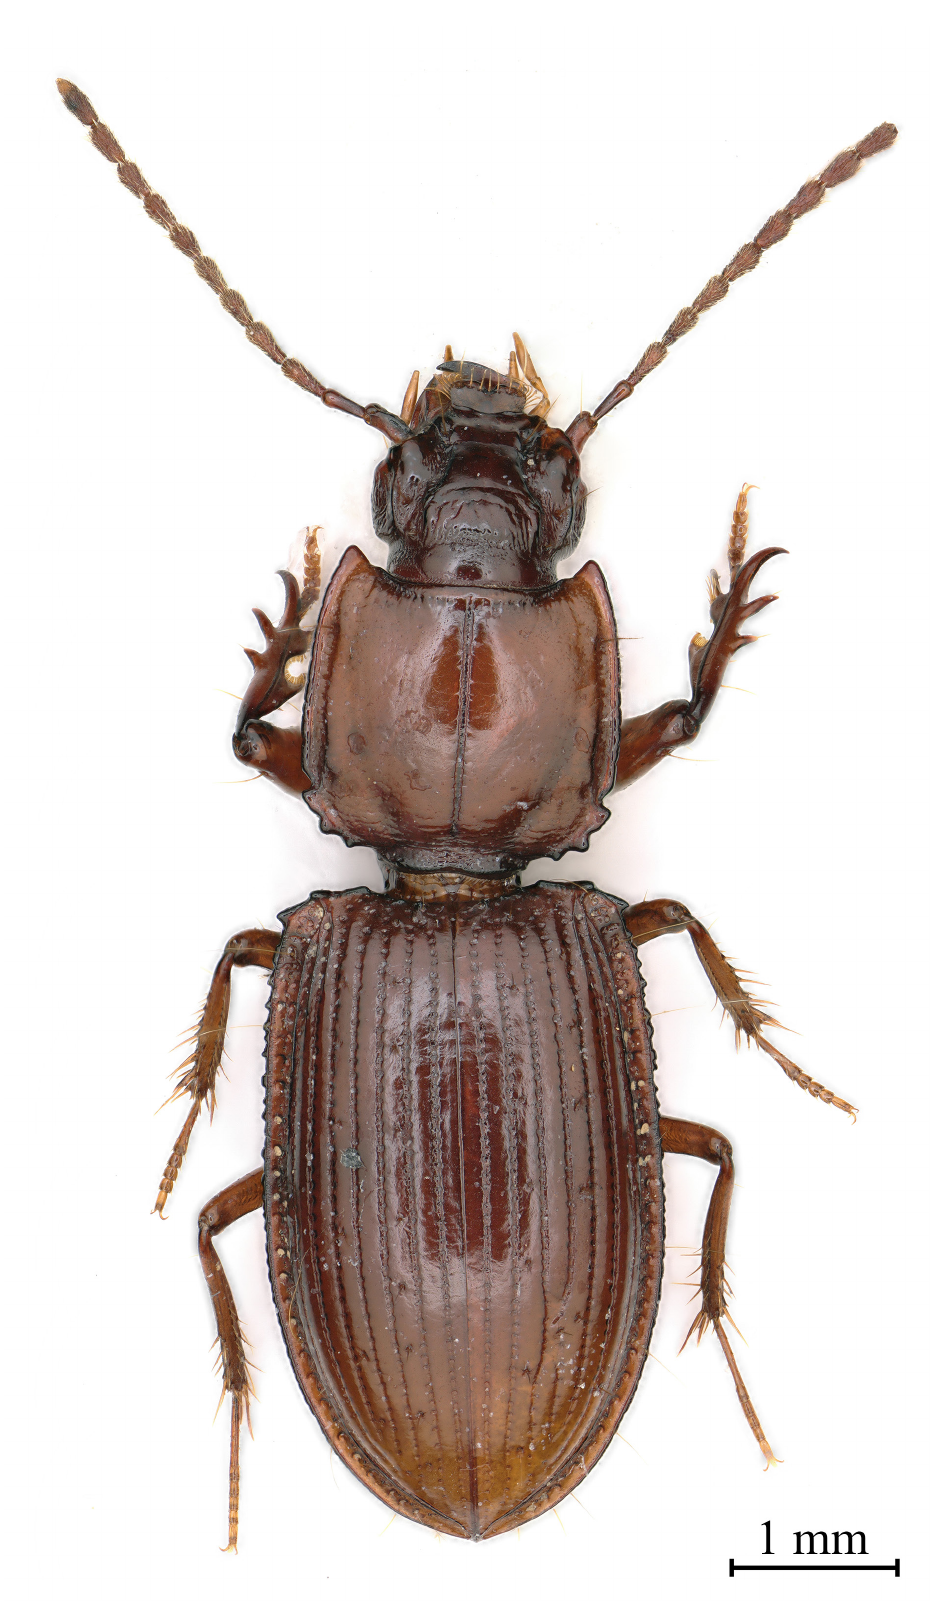
Fig. 9. Habitus of Guiodytes inexpectatus Tian & Zhou sp. nov., holotype, ♀